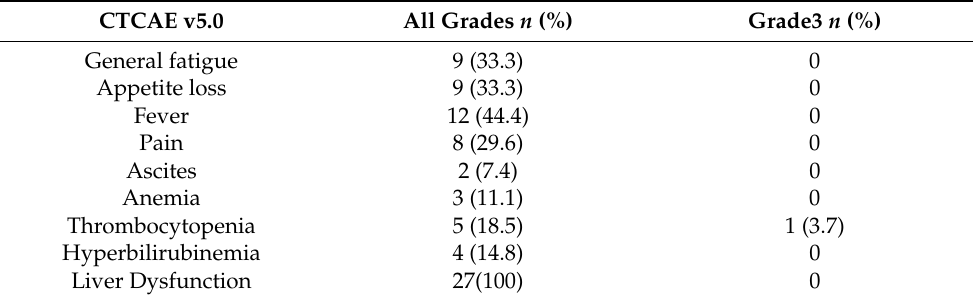
Table 5. Safety profile following the additional cTACE ( n = 27).